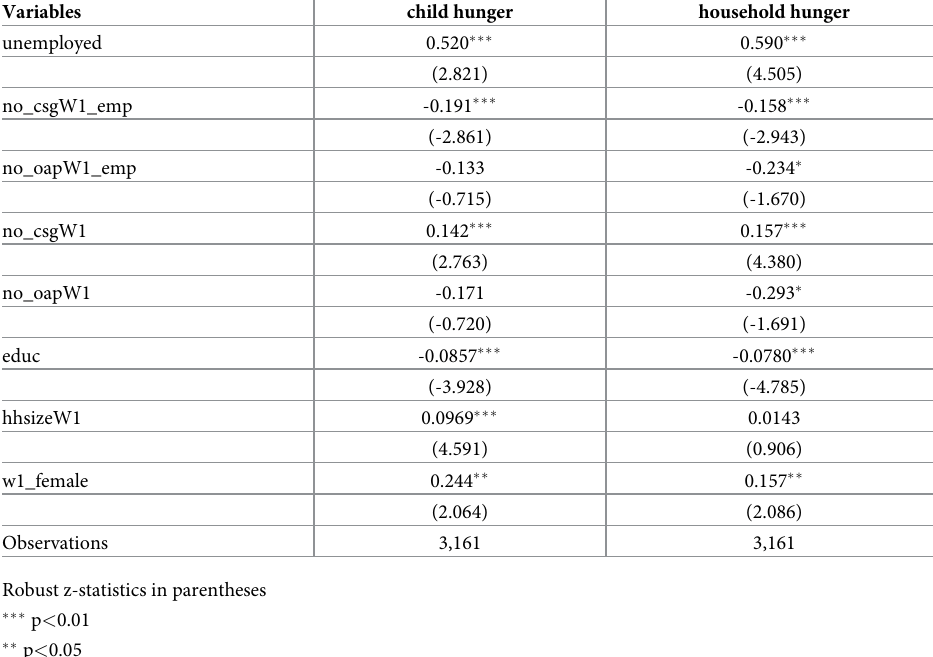
Table 3. Lasso (machine learning) marginal effect estimates of food